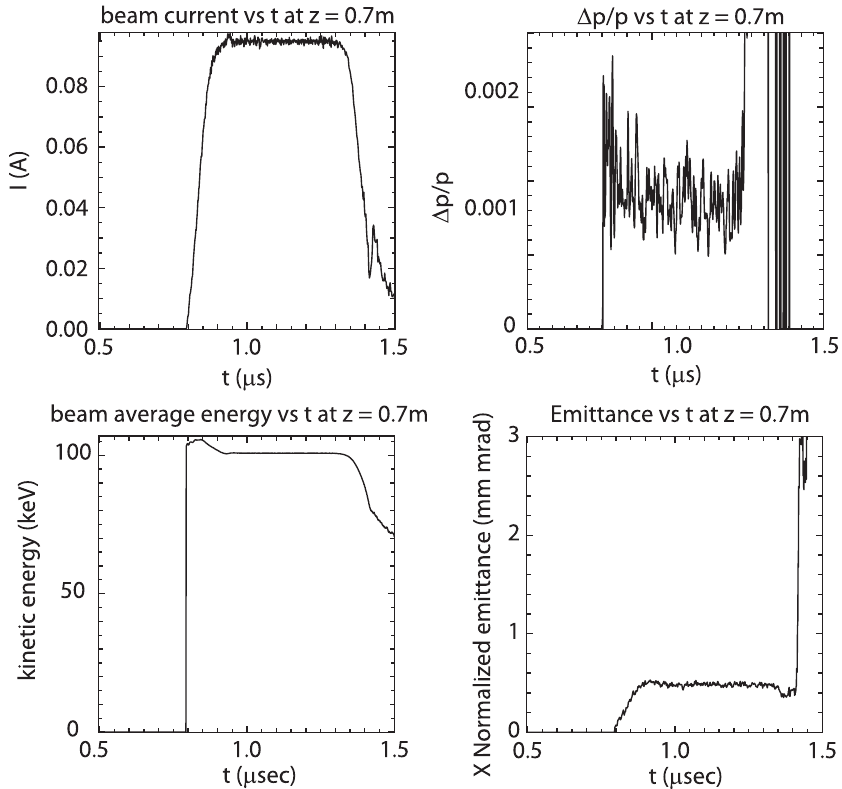
FIG. 9. (Color) The ion beam measured at the beginning of the first helical pulse line; the red part of the trace (in this and subsequent figures) indicates the region with current exceeding 80% of the peak current of the ion beam.